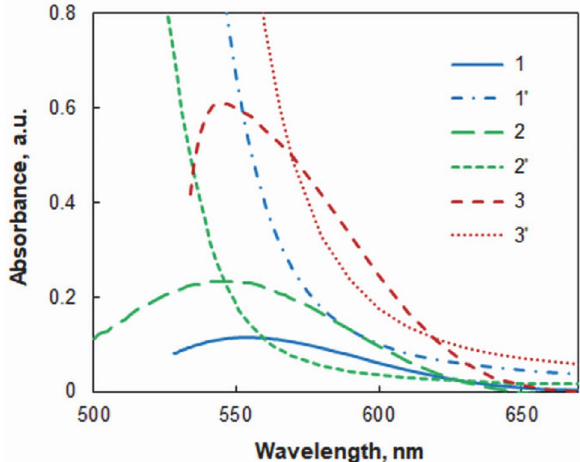
Figure 1. Absorption spectra in isobutanol of complexes against blanks (1–3; c V = 2 × 10 −5 mol dm −3 ) and blanks against isobutanol (1’–3’). (1, 1’) c TAO = 1.6 × 10 −3 mol dm −3 , pH 5.0, extraction time t = 120 sec; (2, 2’) c TAO = 2.0 × 10 −4 mol dm −4 , pH 5.0, c A336 = 1.3 × 10 −2 mol dm −3 , extraction time t = 30 sec; (3, 3’) c TAO = 1.6 × 10 −3 mol dm −3 , pH 5.0, c A336 = 1.3 × 10 −2 mol dm −3 , extraction time t = 30